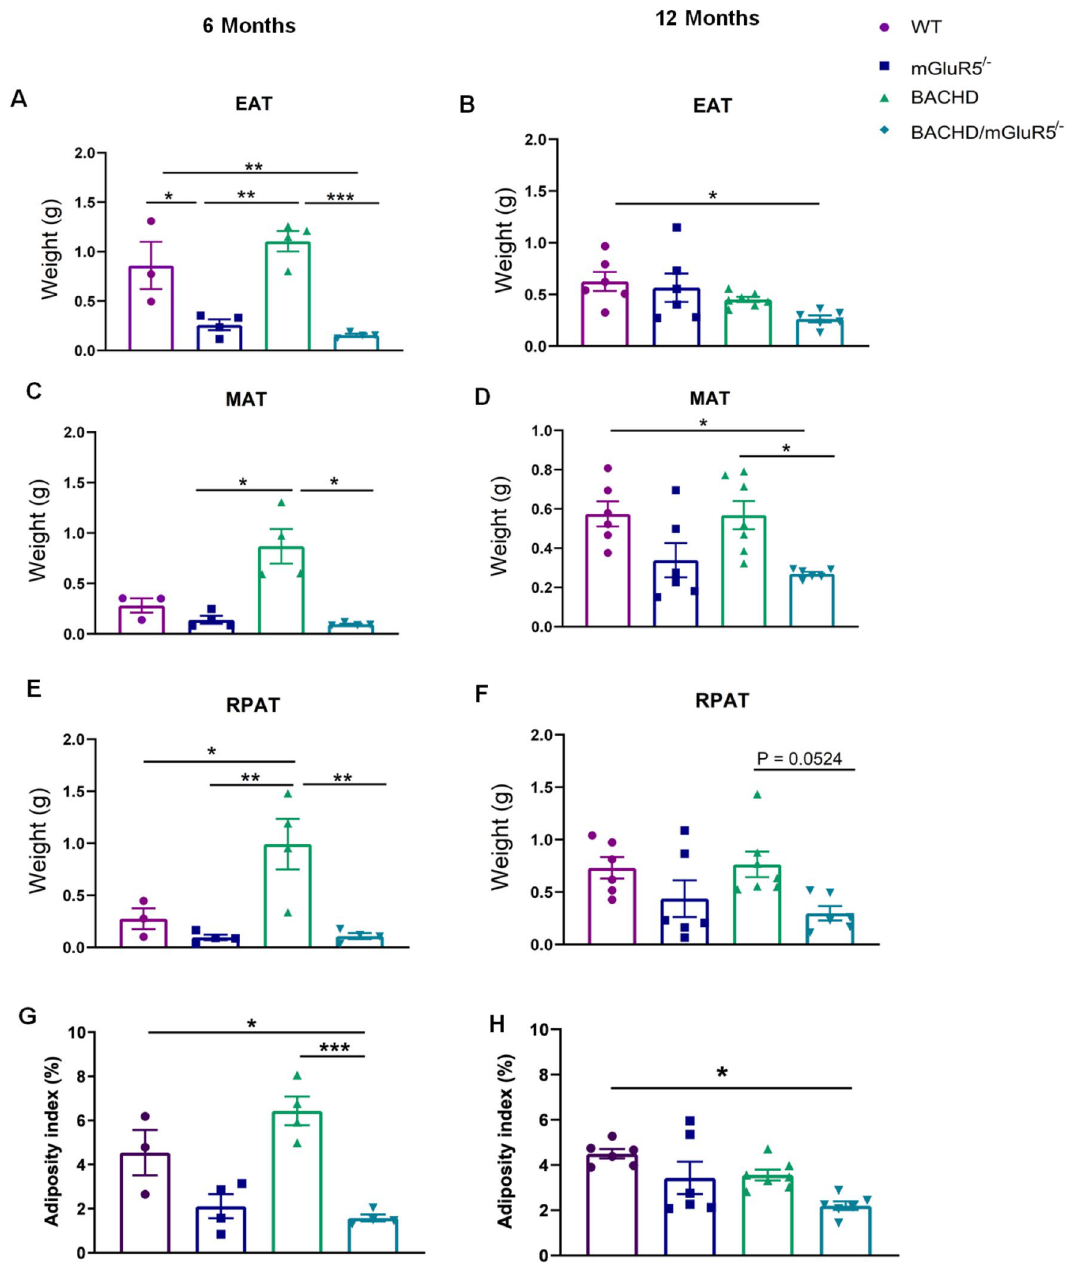
Figure 3. mGluR5 genetic deletion reduces fat pads wet weight and adiposity indices in BACHD mice at 6 months of age. All fat pads were individually weighted, and the adiposity index was obtained by the sum of the weight of visceral adipose tissue fat pads (VAT), normalized by body weight of individual mice. ( A – F ) measurement of the wet weight of the epididymal (EAT), mesenteric (MAT), retroperitoneal (RPAT) adipose tissue of WT, mGluR5, BACHD and BACHD/mGluR5 −/− mice, at 6 and 12 months of age, left and right columns, respectively. ( G, H) Adiposity index of WT, mGluR5 −/− , BACHD and BACHD/mGluR5 −/− mice from 6 and 12 months of age. Error bars represent the mean ± SEM; n = 3–8. One-Way ANOVA followed by Bonferroni post test ( A , B , D , E, G ), and Krustal-Wallis followed by Dunn’s post test ( C , F , H ). *p < 0.05, **p < 0.01, ***p < 0.001; ****p <